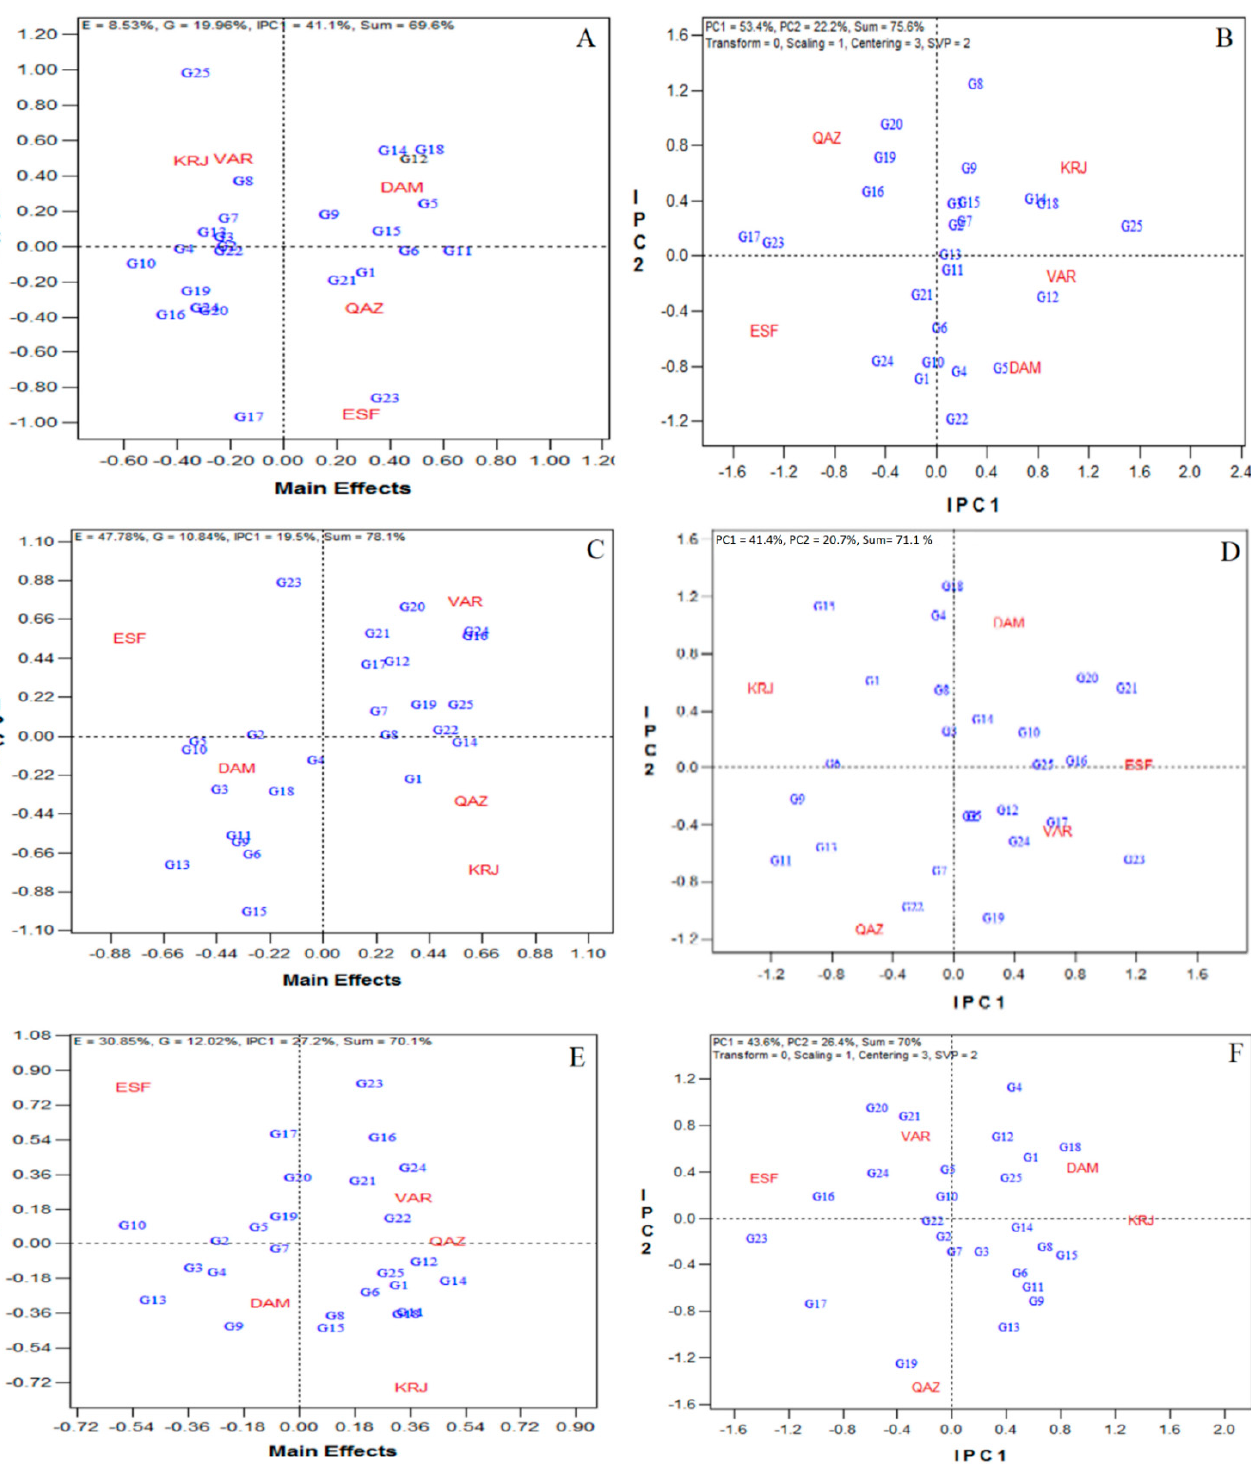
Figure 6. AMMI1 and AMMI2 of genotypes and environments based on biplot analyses. ( A ):